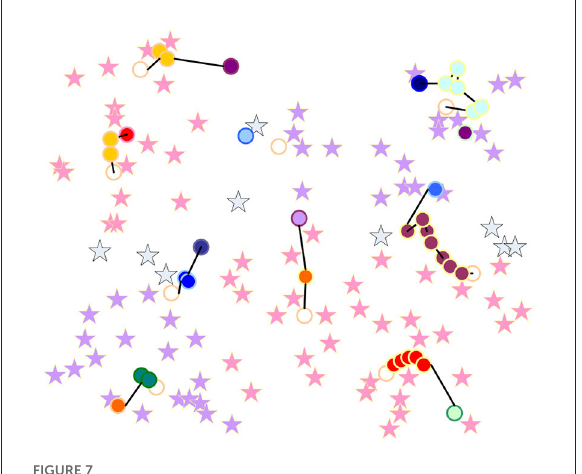
FIGURE5 An example of the K-means clustering algorithm.